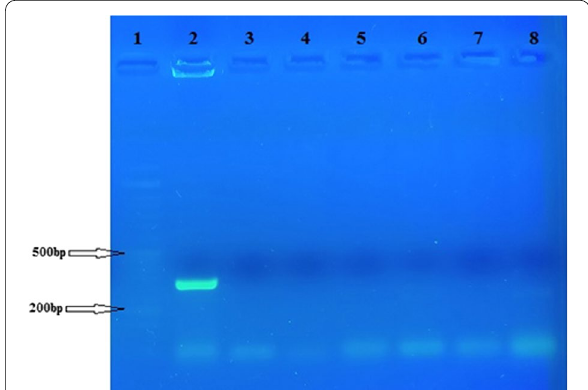
Fig. 3 PCR analysis of hairy roots using the virG ‑specific gene primer. Lane 1, 50 bp DNA ladder (Sinaclone); lane 2, Ri plasmid of R. rhizogenes as positive control; lane 3 and 4, DNA‑free PCR reaction as negative control; lanes 5, 6, 7, and 8, hairy roots from